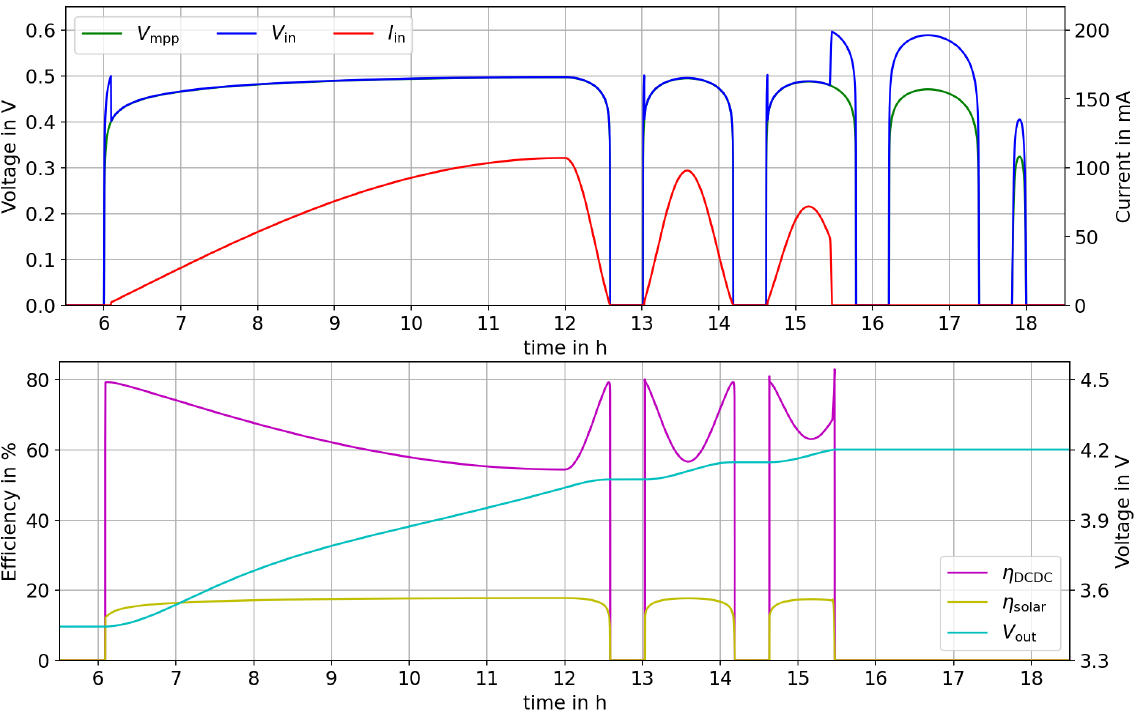
Figure 9. Simulation results showing I in , V in and V mpp in the top graph, where V in follows most of the time V mpp (covered by blue line). In the bottom graph, the efficiency of the DC/DC converter η DCDC and of the solar cell η sol is shown besides the battery voltage V out , which is increasing